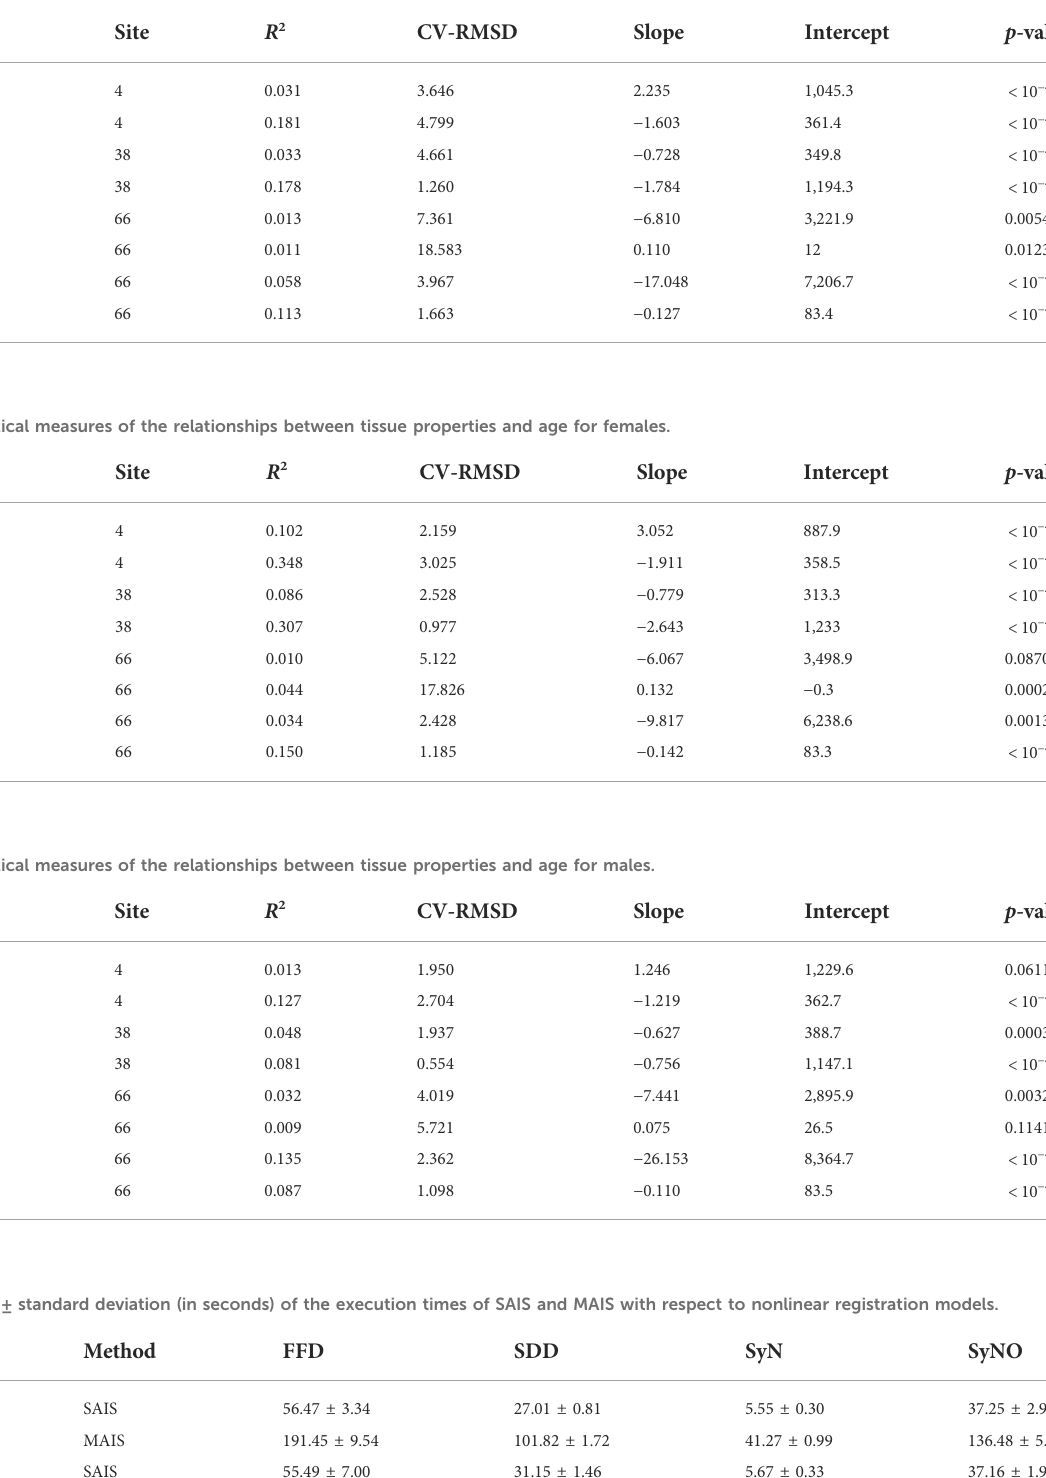
TABLE 11 Statistical measures of the relationships between tissue properties and age for males and females.